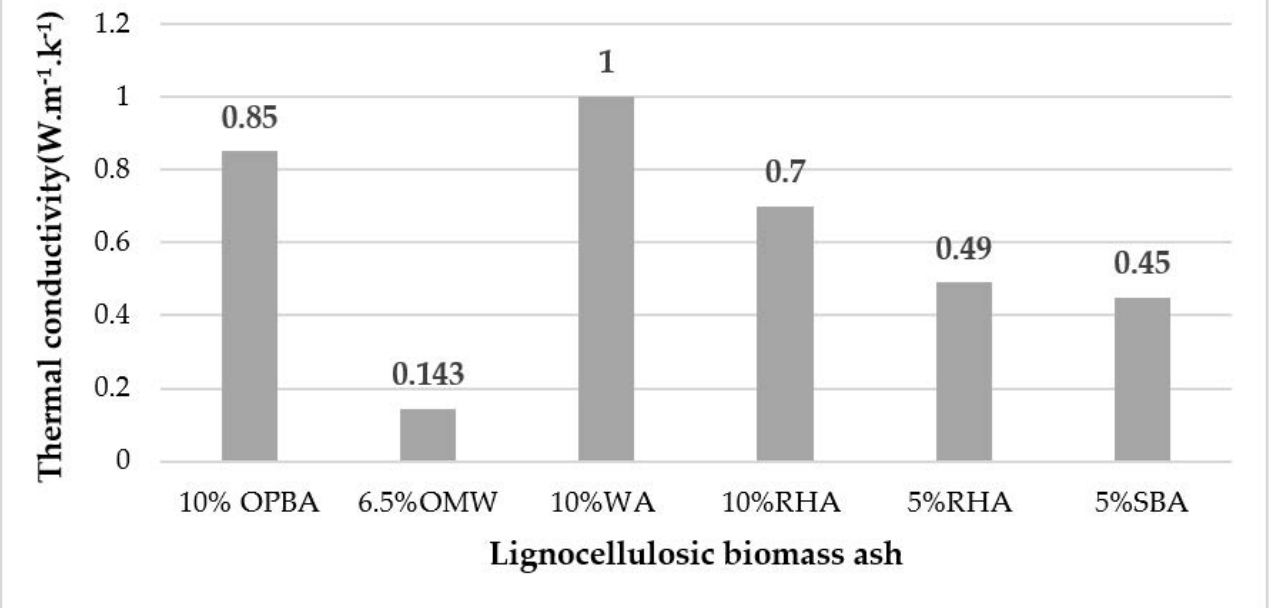
Figure 6. Thermal conductivity for samples made with lignocellulosic biomass ash: 10% OPBA [60], 6.5% OMW [63], 10% WA [65], 10% RHA [65], 5% RHA [68], 5% SBA